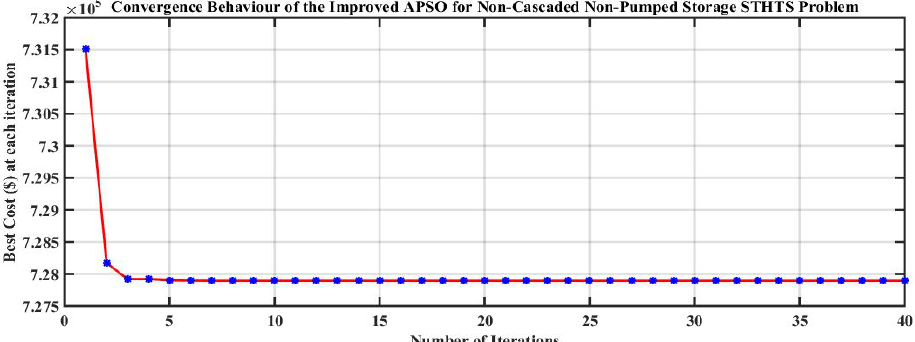
Figure 6. Convergence characteristics of the simple APSO algorithm on the non-cascaded non-pumped STHTS problem taken from [25].